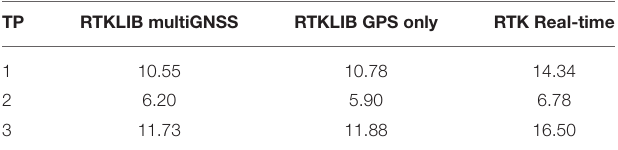
TABLE 6 | Standard deviation in centimeters of the TWTT residuals converted to distance using different GNSS solution type for the three transponders (TP) in box-in